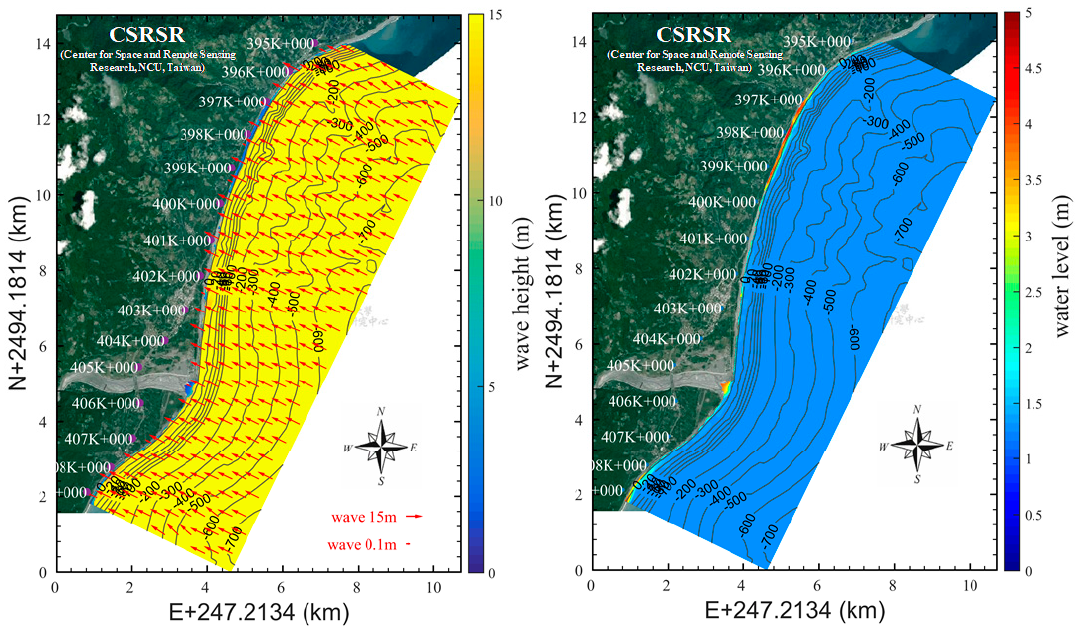
Figure 21. Wave field and water level distribution in Region